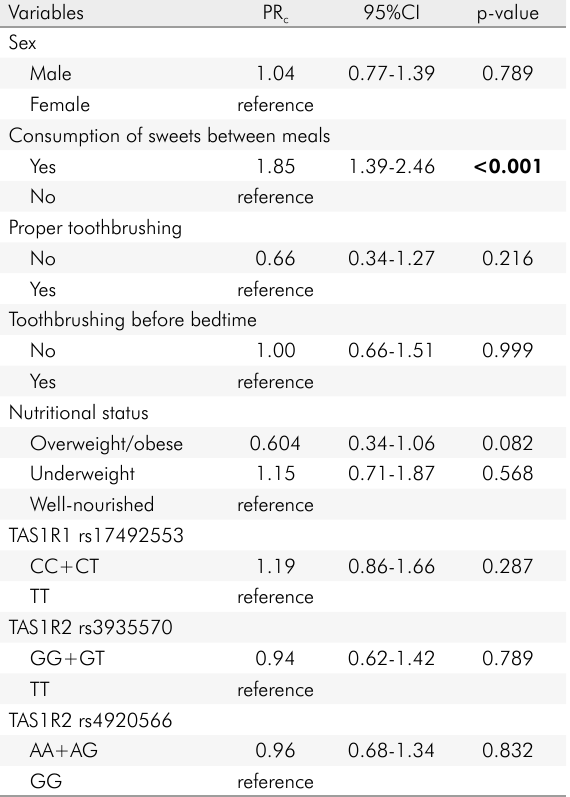
Table 3. Crude prevalence ratio (PR experience in the preschool children subset, considering environmental and genetic